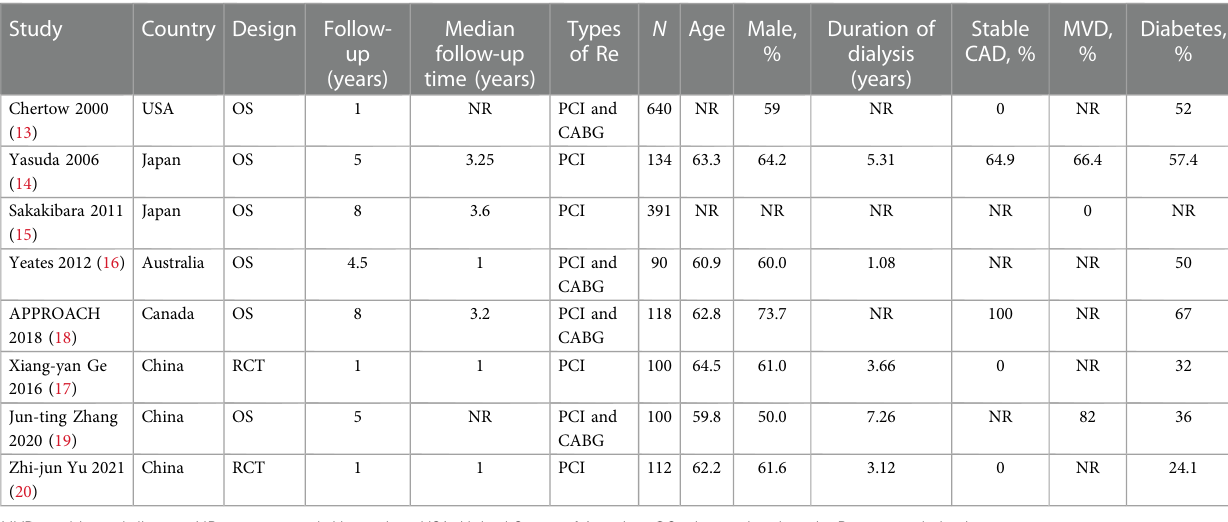
TABLE 2 Baseline characteristic.